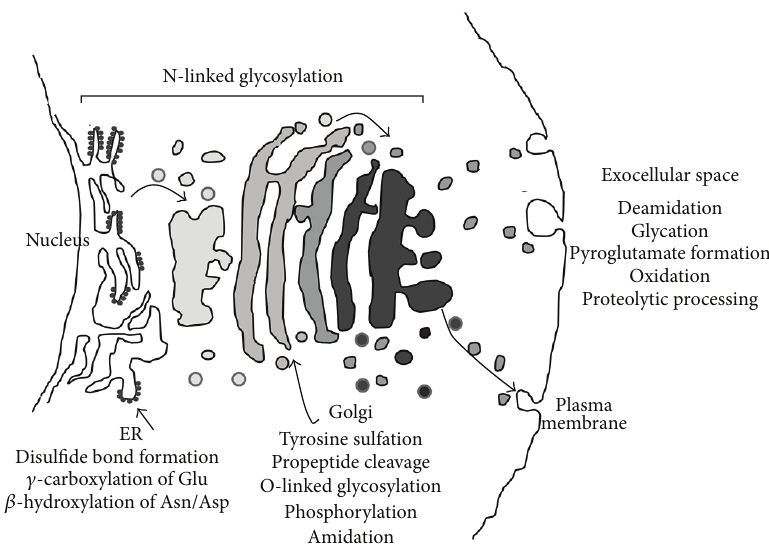
Figure 1: Classification of therapeutic protein modifications along trafficking